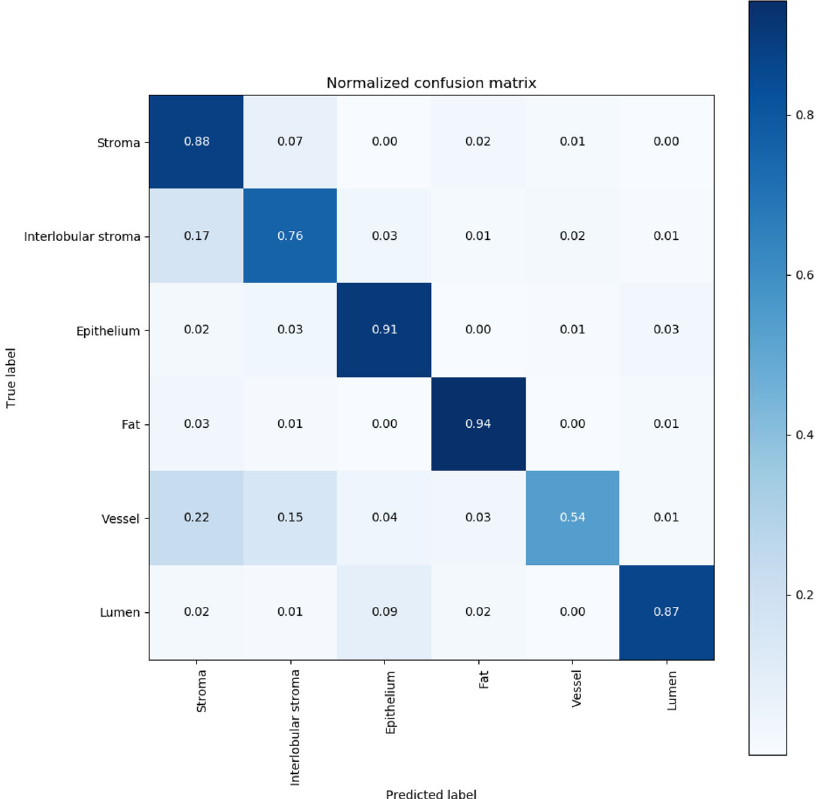
Fig. 2 Confusion matrix of the structure segmentation results: confusion matrix of the segmentation results on the held-out test set. These matrices show how different classes may be misclassi fi ed. The vertical axis displays the ground truth label and the horizontal axis shows the label that was predicted by the neural network. As an example: for the lumen class 85% of the pixels are correctly classi fi ed and 10% of the pixels are misclassi fi ed as epithelium.